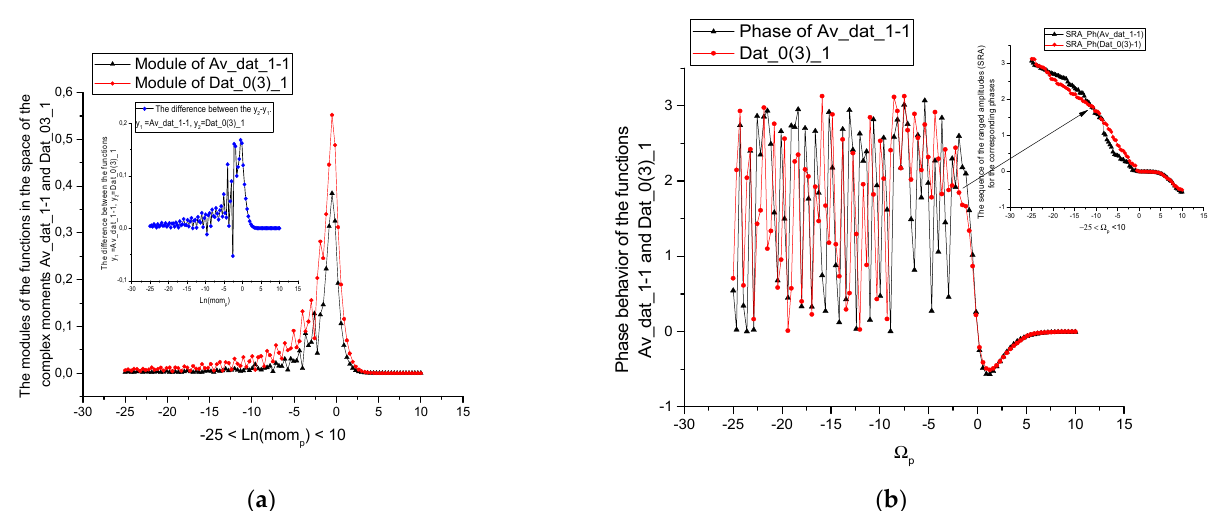
Figure 4. ( a ). The behavior of the initial functions (see Figure 2 above) in the space of the complex moments. Here, the corresponding modules are shown. On the left corner above we show the difference between these functions. ( b ). The behavior of the initial functions (see Figure 2 above) in the space of the complex moments. Here, the corresponding phases are shown. On the left corner above we show the sequences of the range amplitudes calculated for these functions. These functions are sensitive for evaluation of the differences between them.